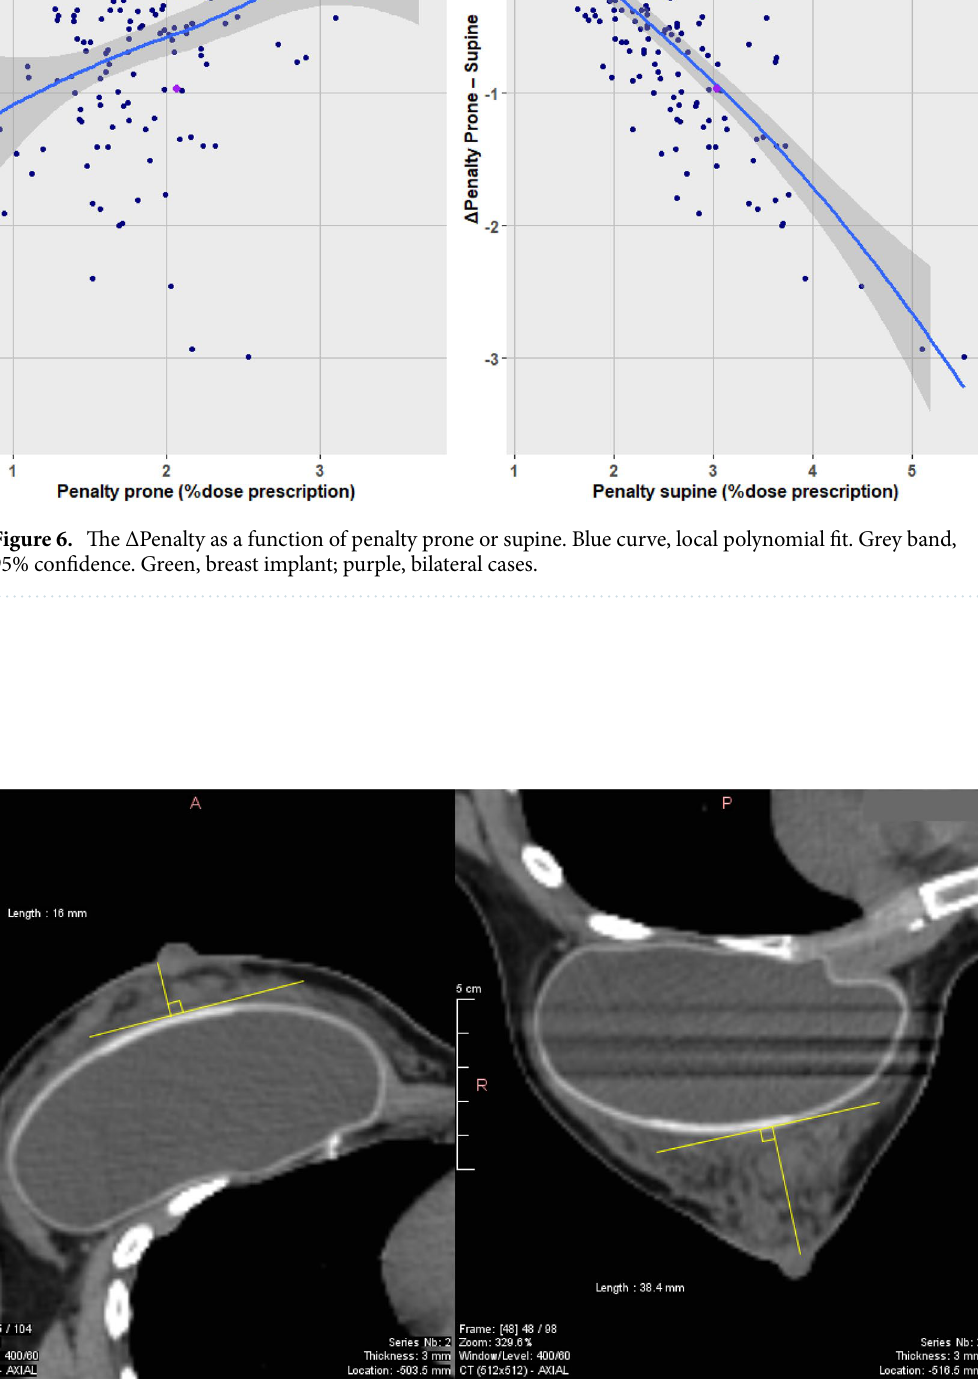
Figure 7. Breast augmentation implant supine and prone. Supine (left) and prone (right) CT of case 112, green color-coded in Figs. 3, 4 and 6. The breast depth measured from the pleura was 71 mm supine vs. 94 mm prone. The depth remeasured from the implant anterior surface is 16 mm supine vs. 38 mm prone, indicating a shift with gravity of >